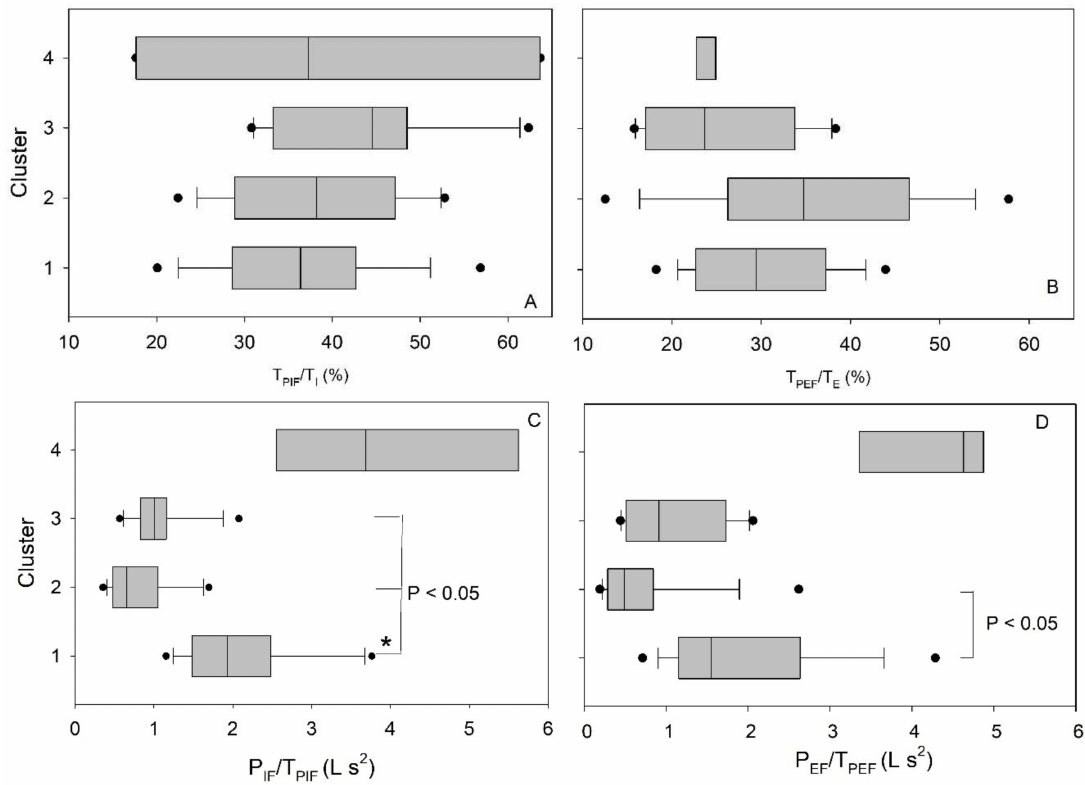
Figure 6. ( A ) T PIF /T I , ( B ) T PEF /T E , ( C ) P IF /T PIF , ( D ) P EF /T PEF . Cluster 1 was significantly different from Cluster 2. No significant differences were found ( p > 0.05), except where